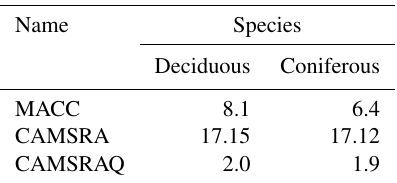
Table 3. Relative percentage difference in CUO 0 for the different ozone reanalysis products compared to observed ozone. Boreal pa- rameterizations of deciduous and coniferous trees are taken from Mills et al. (2017).